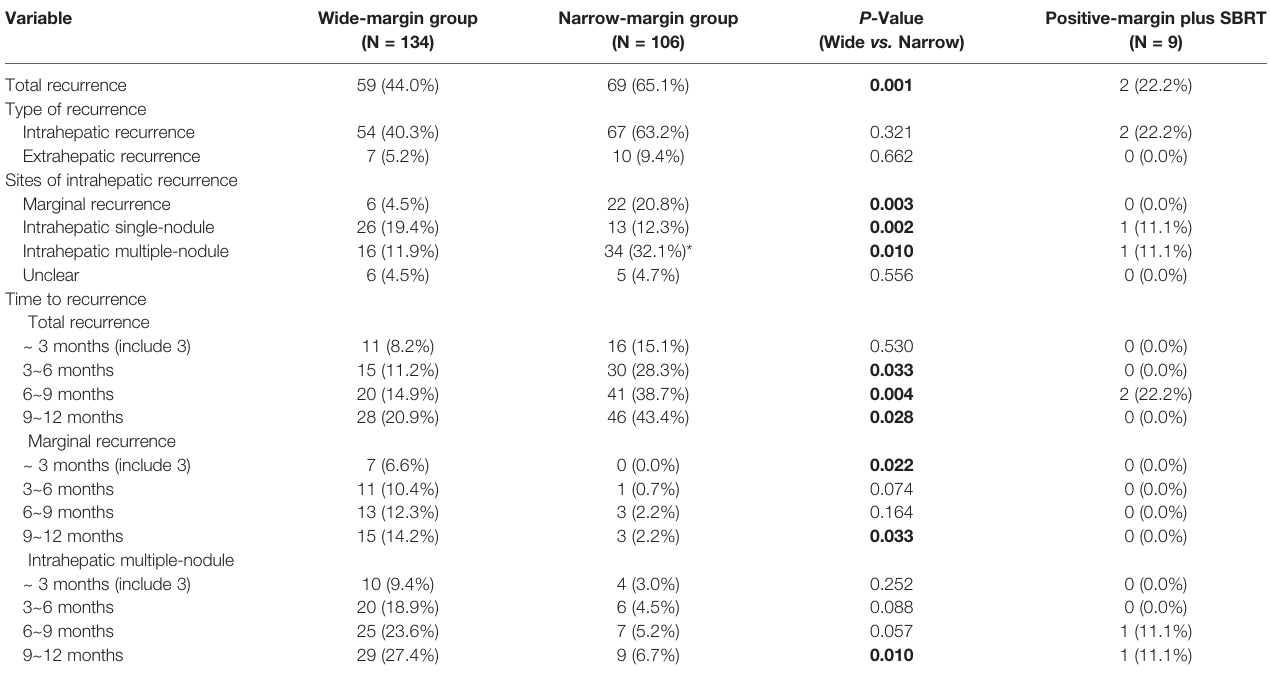
TABLE 2 | Patterns of recurrence of the wide-margin, narrow-margin, and positive-margin plus stereotactic body radiotherapy (SBRT)